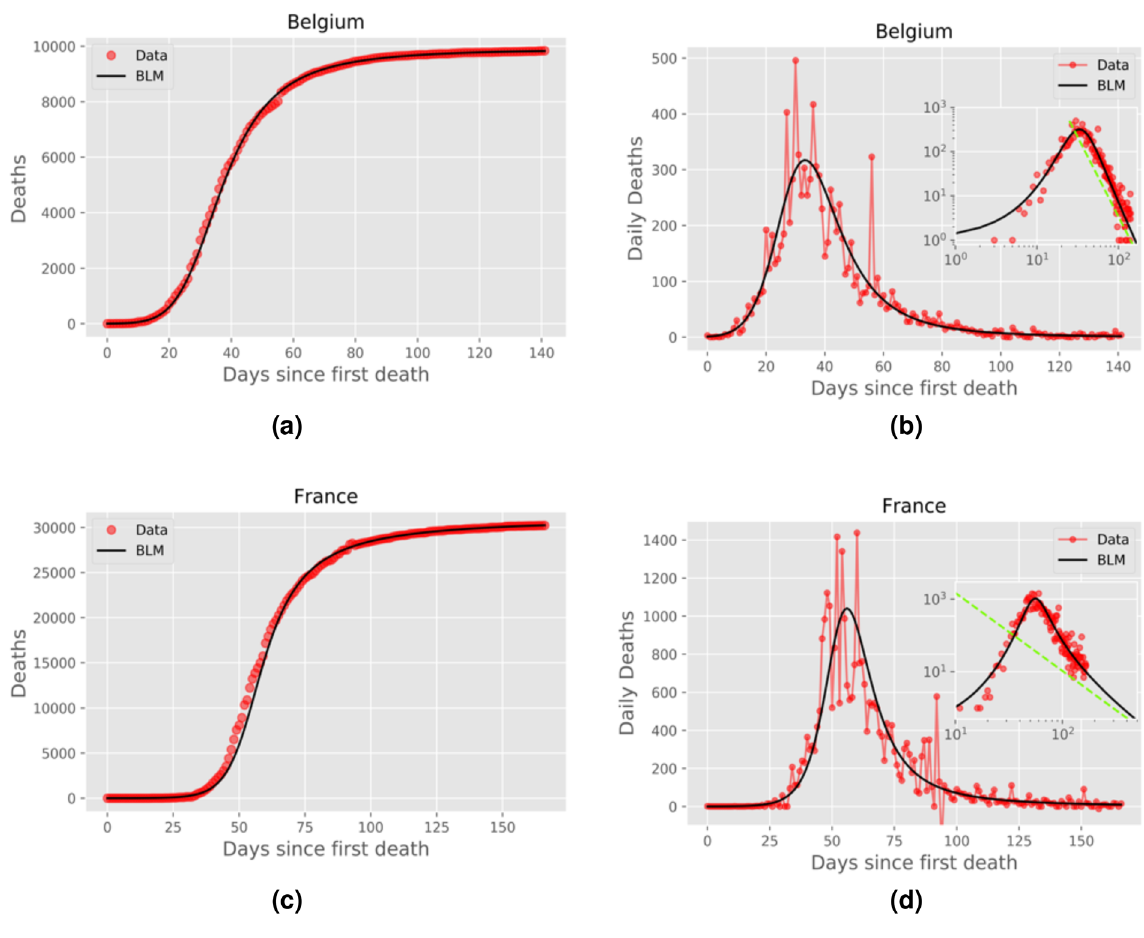
Figure 4. Same as in Fig. 2 for Belgium and France.